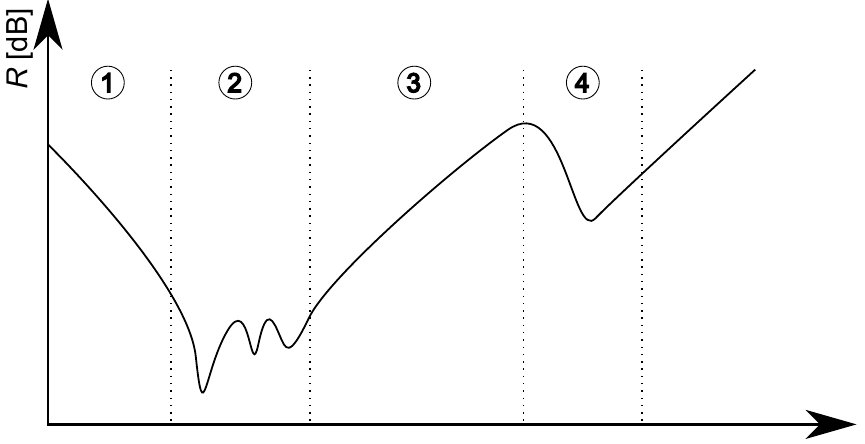
Figure 4. Sound transmission loss of a single panel: (1) stiffness controlled region, (2) resonances region, (3) mass law region, (4) coincidence